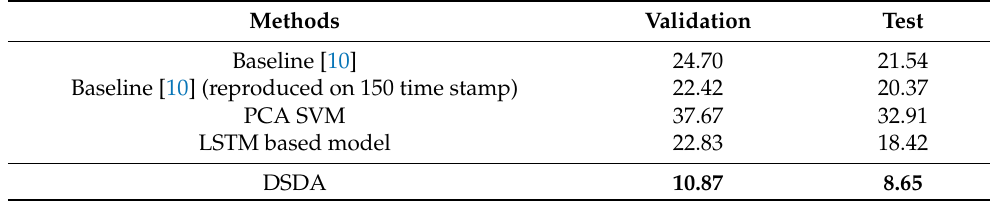
Table 4. Error rate (%) on the IDRad